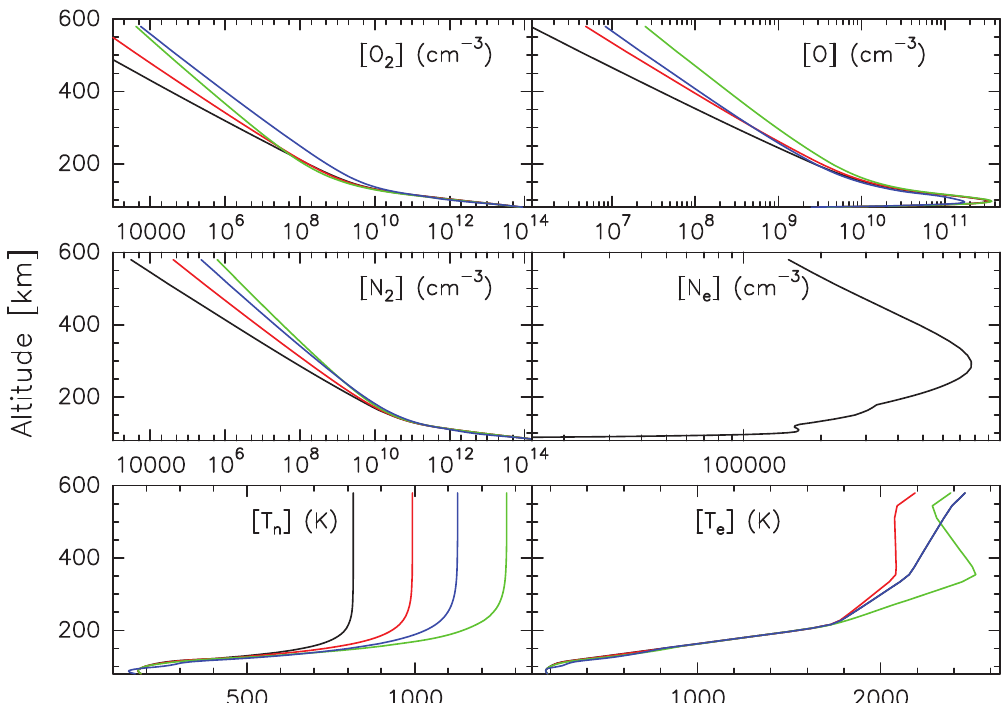
Fig. 6. The four cases under study. The color code is: F 10.7 = 80, Ap = 3 (black), F 10.7 = 120, Ap = 3 (red), F 10.7 = 200, Ap = 3 (green) and F 10.7 = 80, Ap = 300 (blue). Variation of the O 2 density (upper left), O (upper right), N 2 (middle left) and electron density (middle right). Bottom panels: Neutral temperature (left) and electron temperature (right). Since the values provided by IRI only depend on F 10.7 and not on Ap , the blue and the black lines are superposed in the temperature and electron density curves.